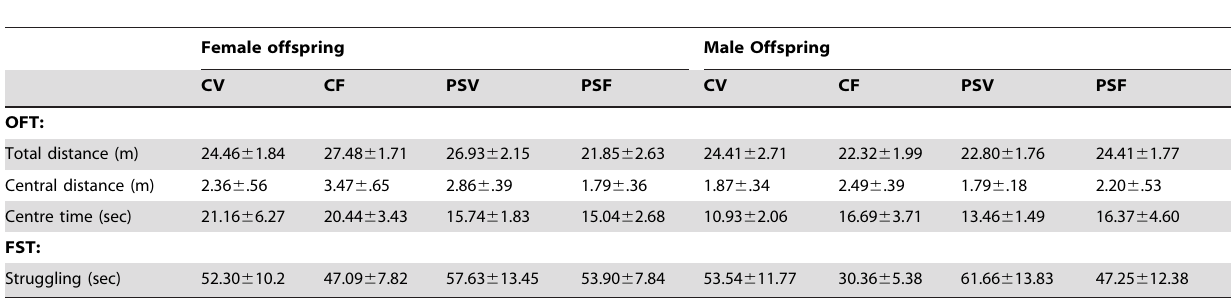
Table 2. Mean ( 6 SEM) total distance and time in the centre of the OFT and percent time spent struggling during the FST.